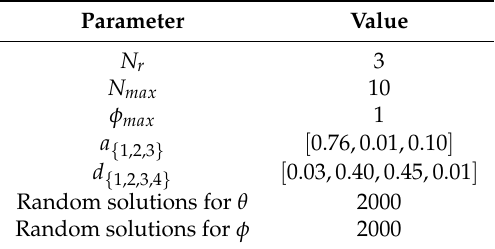
Table 2. Simulation parameters for the one-shot